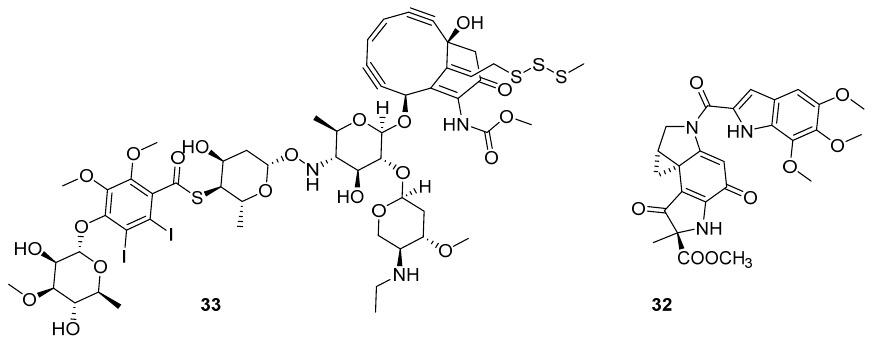
Figure 1. Cartoon illustrating the structure of an antibody–drug conjugate (ADC) drug. Figure 2. Examples of payloads in ADCs. Figure 2. Examples of payloads in